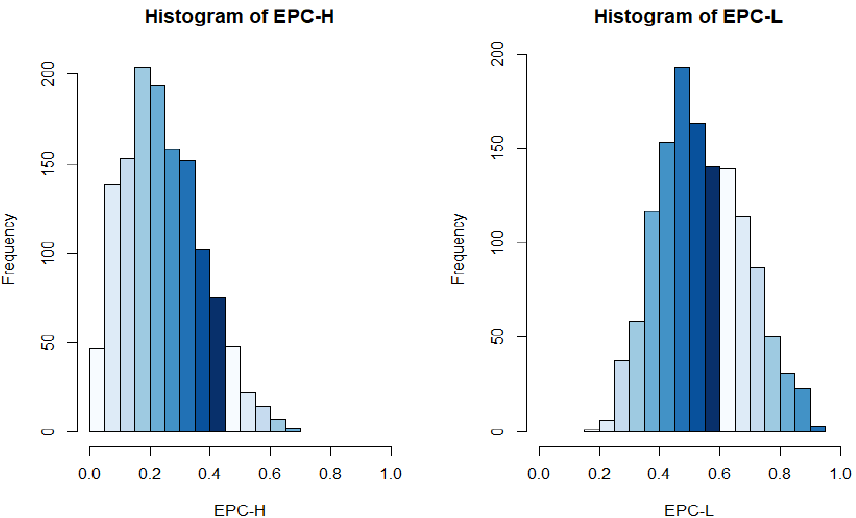
Figure 8. Histogram for high energy performance certificates (EPC-H) and low energy consumption performance certificates (EPC-L).